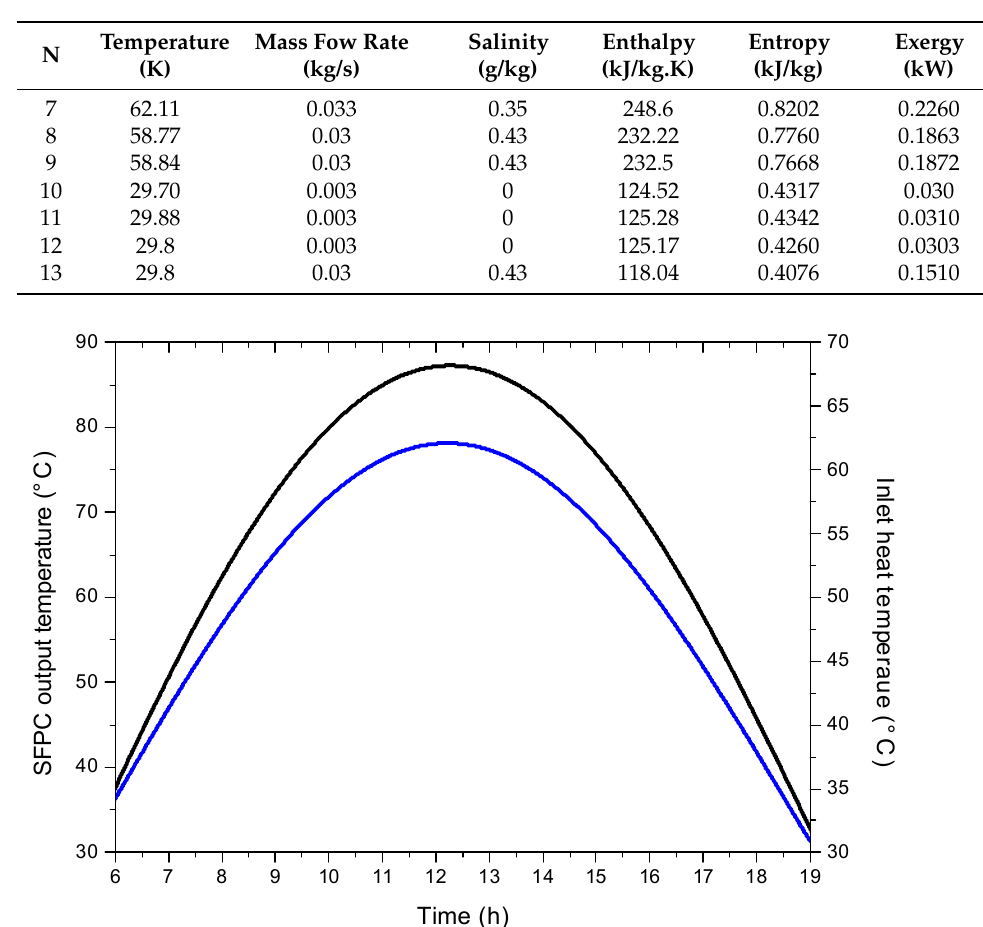
Figure 5. Variation of output inlet temperatures of the hot channel over the local time.